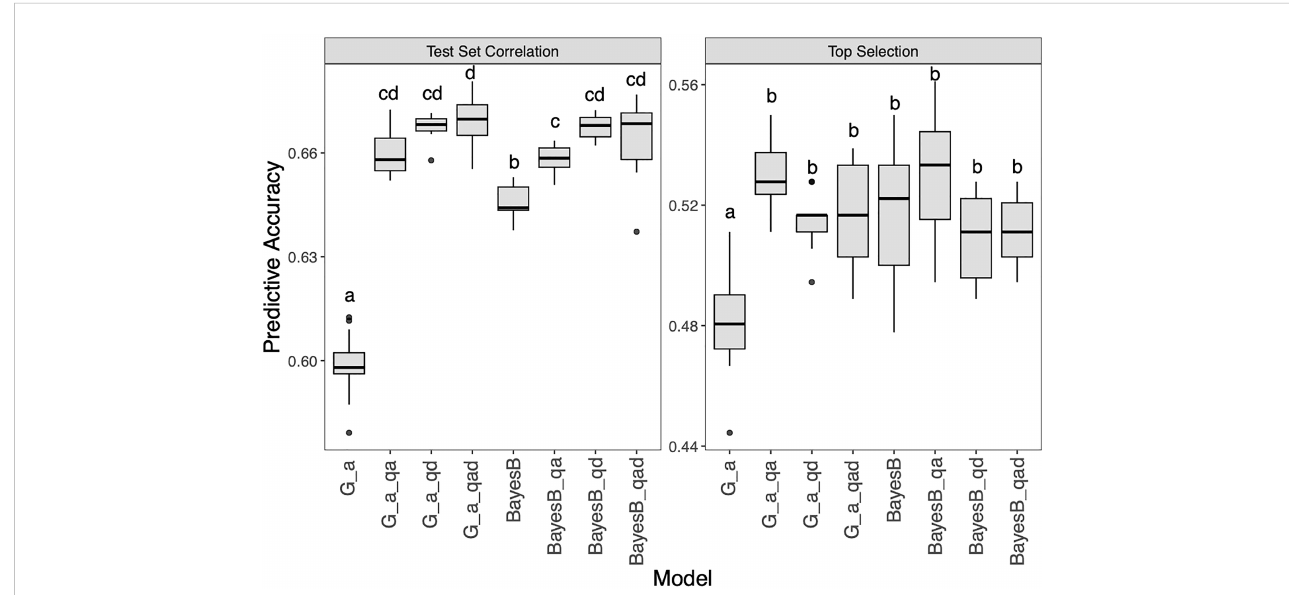
FIGURE 7 Genomic prediction study in hybrid panel with adding QTL as fi xed factor into G_A and BayesB models for Southern Corn Rust (SCR) resistance. The left is prediction accuracy for test set and the right is accuracy for top selection.